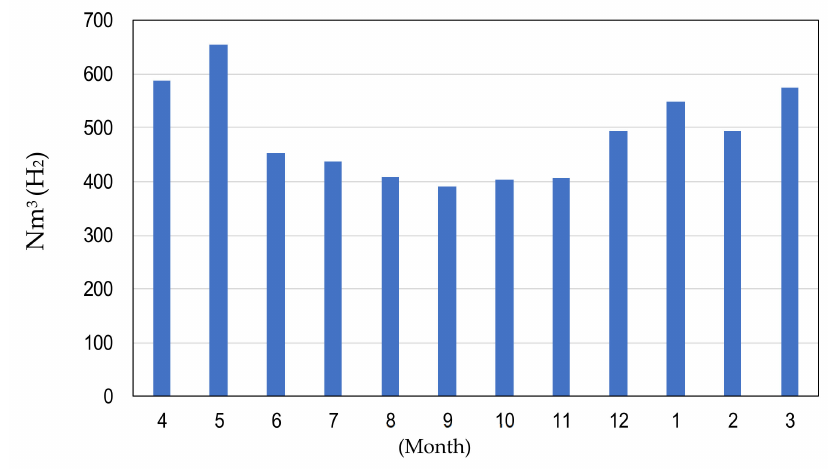
Figure 10. Hydrogen production using surplus electricity (monthly).